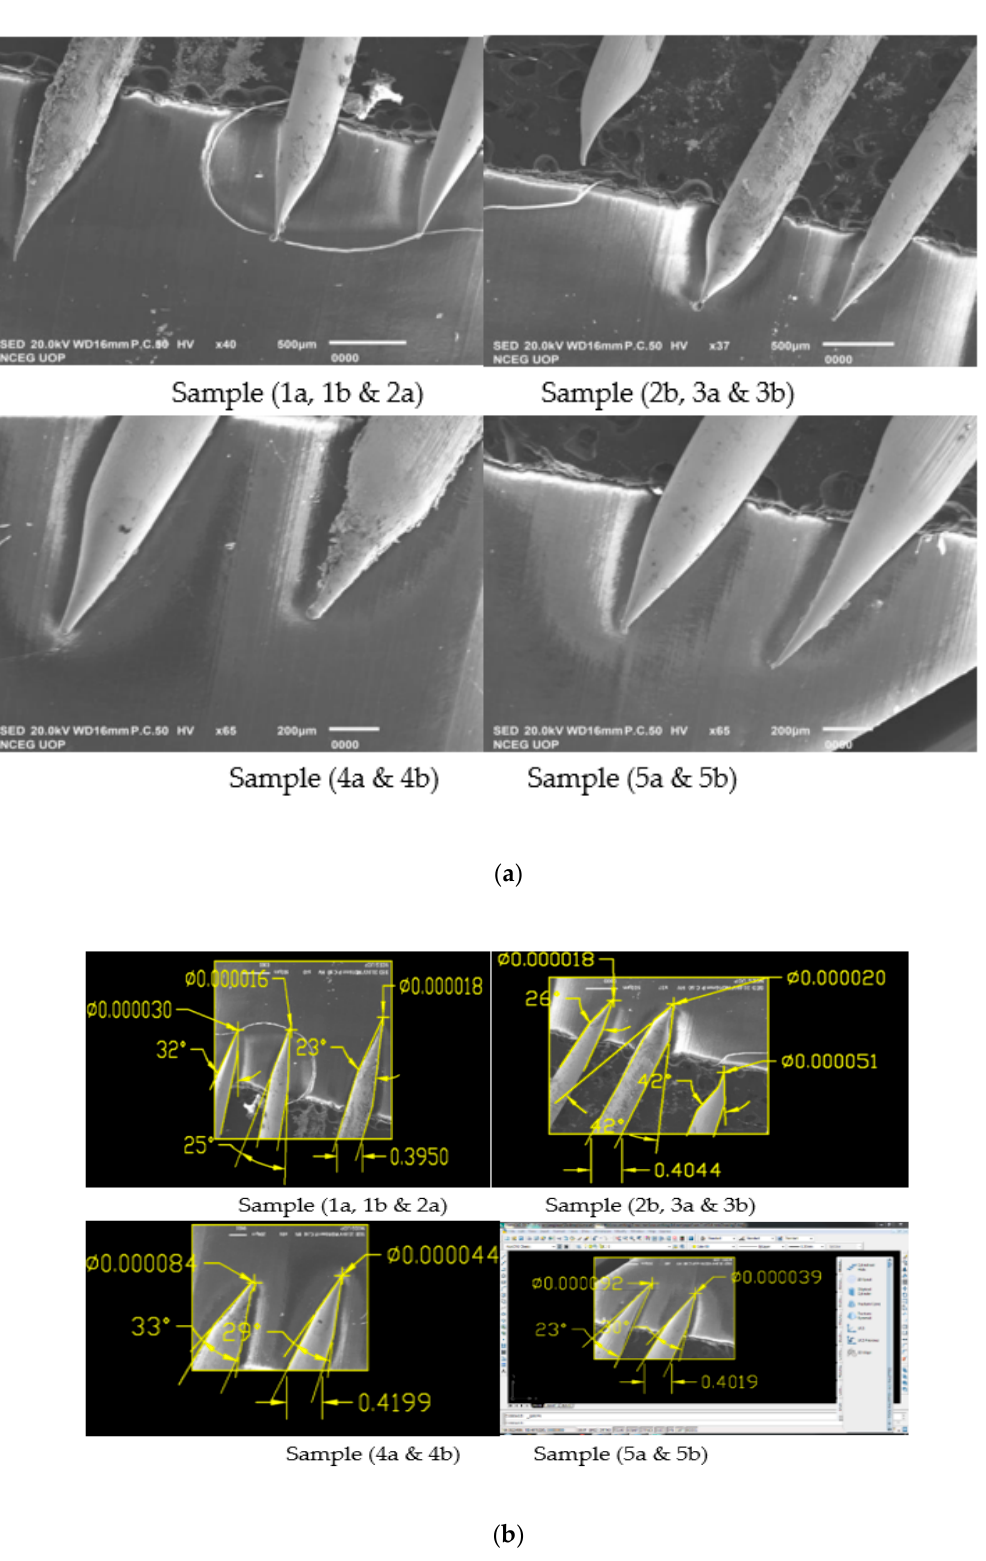
Figure 6. ( a ) SEM Images showing Sample 3b having applied voltage of 8.5 V in 2M NaOH solution; ( b ) SEM Images